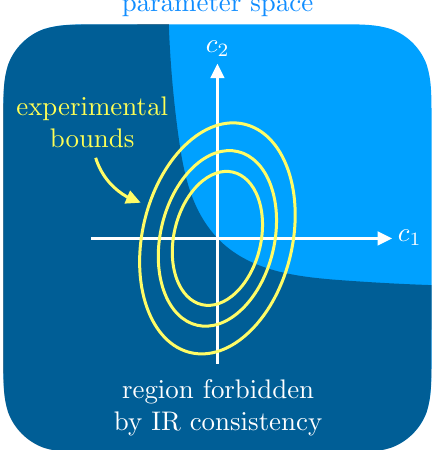
Figure 1 . Schematic depiction of bounds derived in this work. For the example of an observable sensitive to two SMEFT operators, and , data can weigh directly on the allowed parameter O 1 O 2 space for these operators, as shown by the yellow contours in the (cid:12)gure. However, much of the parameter space is inconsistent with fundamental underlying properties of quantum (cid:12)eld theory, and any theory with couplings in the forbidden region would depart signi(cid:12)cantly from standard assumptions about the form of UV physics (causality, unitarity, etc.). Consequently, our bounds can be viewed as placing strong theoretical priors on the parameter space of the